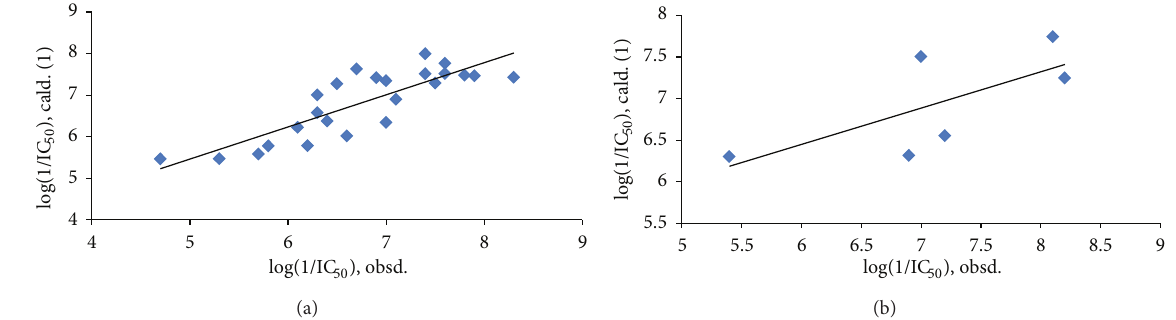
Figure 2: A plot between observed and predicted H + /K + -ATPase inhibition activities of compounds of Table 1: (a) for training set; (b) for test